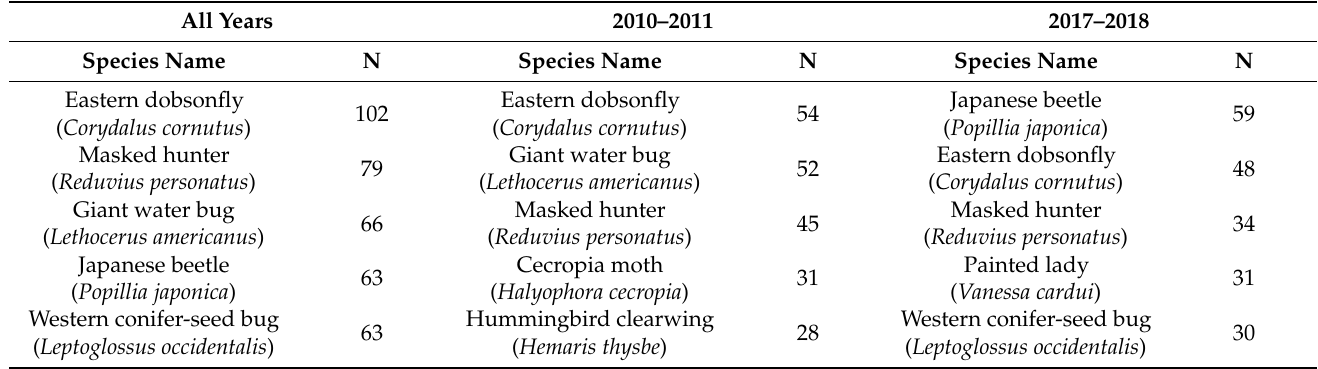
Table 2. Comparison of the five most frequent species for the two focus periods and for all years, based on the number of requests (N) received by the Montreal Insectarium’s Entomological Information Service.